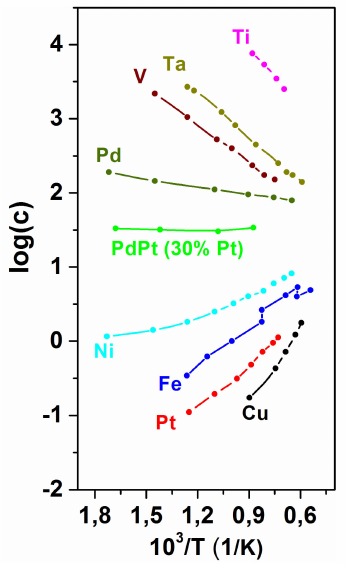
Figure 33. Equilibrium H content for 3d and 4d transition elements as a function of temperature (1 atm ambient pressure). Adopted from [118], with permission from Red Globe Press,